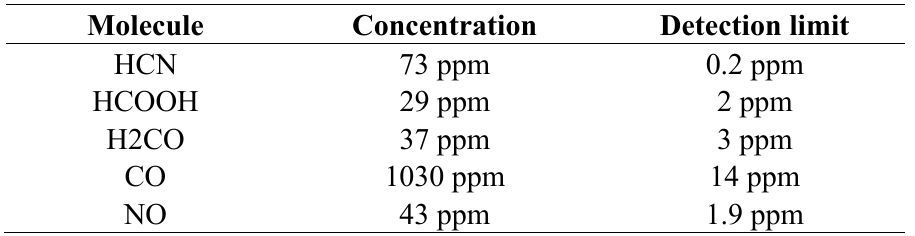
Table 1 . Measured concentration of species contained in the cigarette